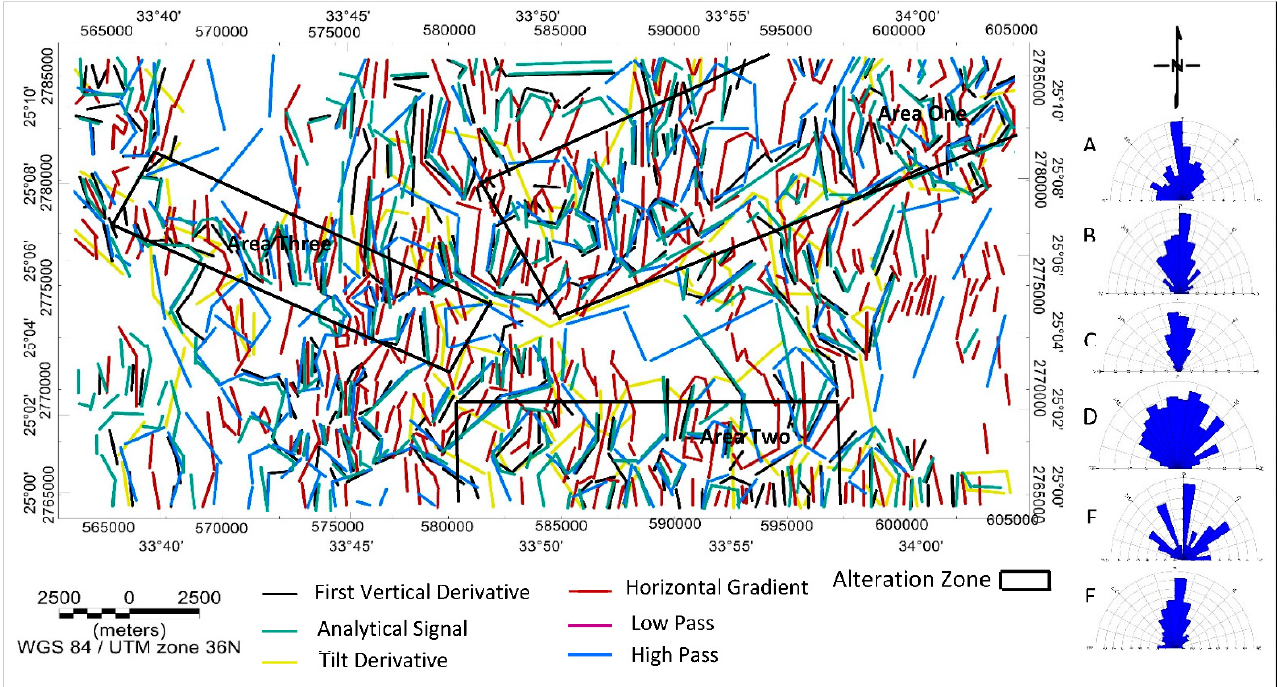
Figure 11. A map depicting the faults, dykes, and shears beneath the surface of the region under study from the AS ( A ), FVD ( B ), HGD ( C ), High Pass ( D ), Low Pass ( E ), and TDR ( F ) maps, the major and minor trends of the subsurface lineaments are depicted in the rose diagrams ( A – F ).